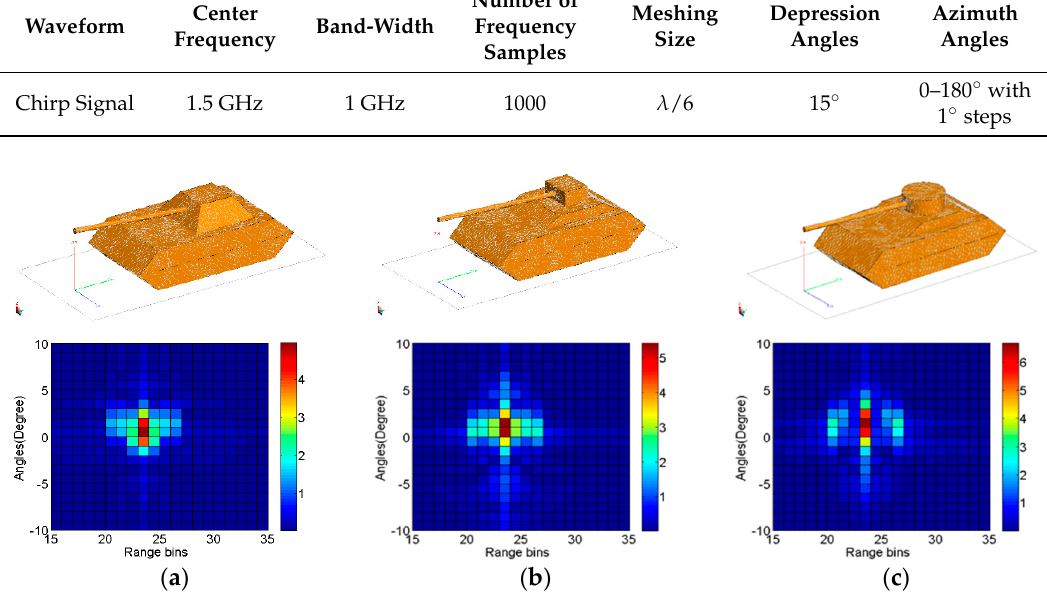
Figure 2. Geometrical models (top) and HRRPs (bottom) of three tanks. ( a ) Tank 1; ( b ) Tank 2; ( c ) Tank 3. Table 2 ． Electromagnetic simulation parameters.